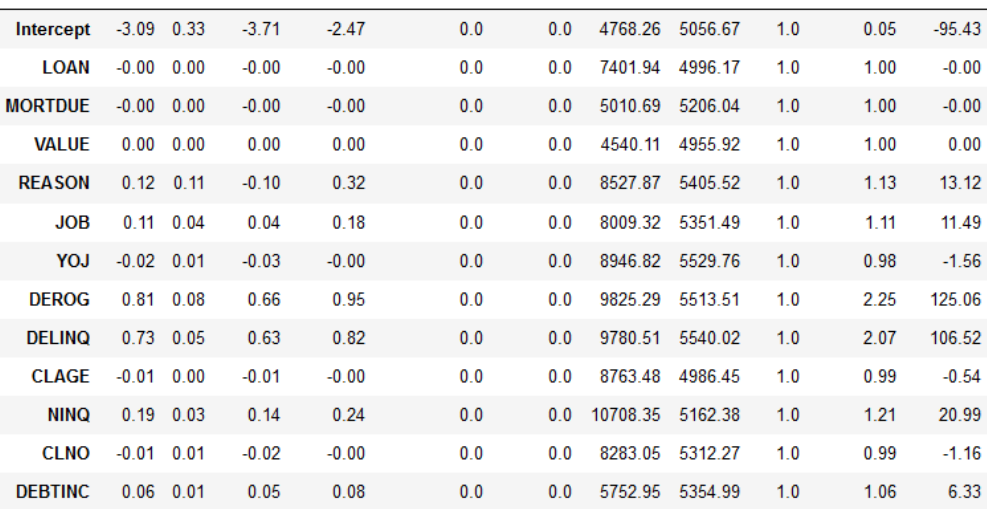
Figure 6. Numerical inspection of sampling from the posterior.